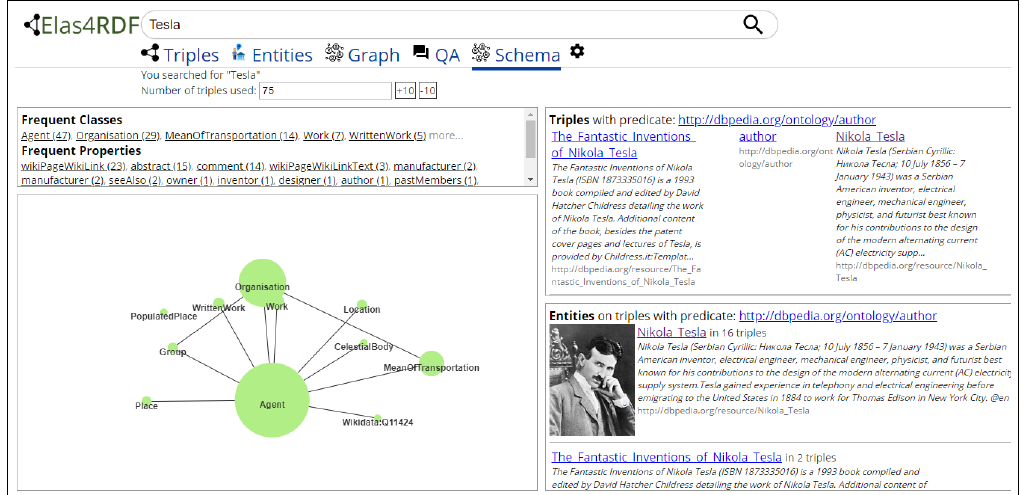
Figure 3. The Schema Tab